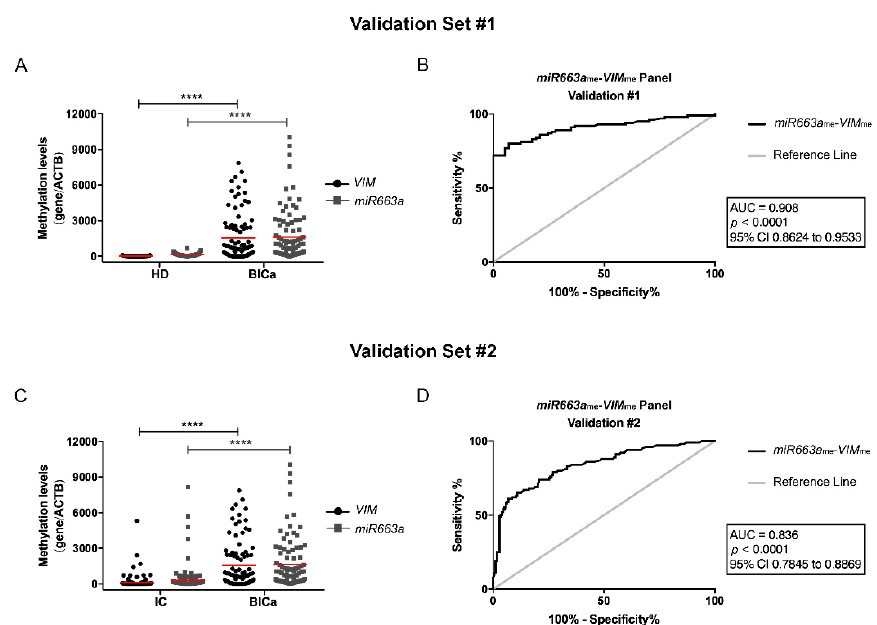
Table 2. Performance of VIM me - miR663a me panel for the detection of bladder cancer in Validation Cohorts #1 and #2. (PPV—positive predictive value; NPV—negative predictive value).